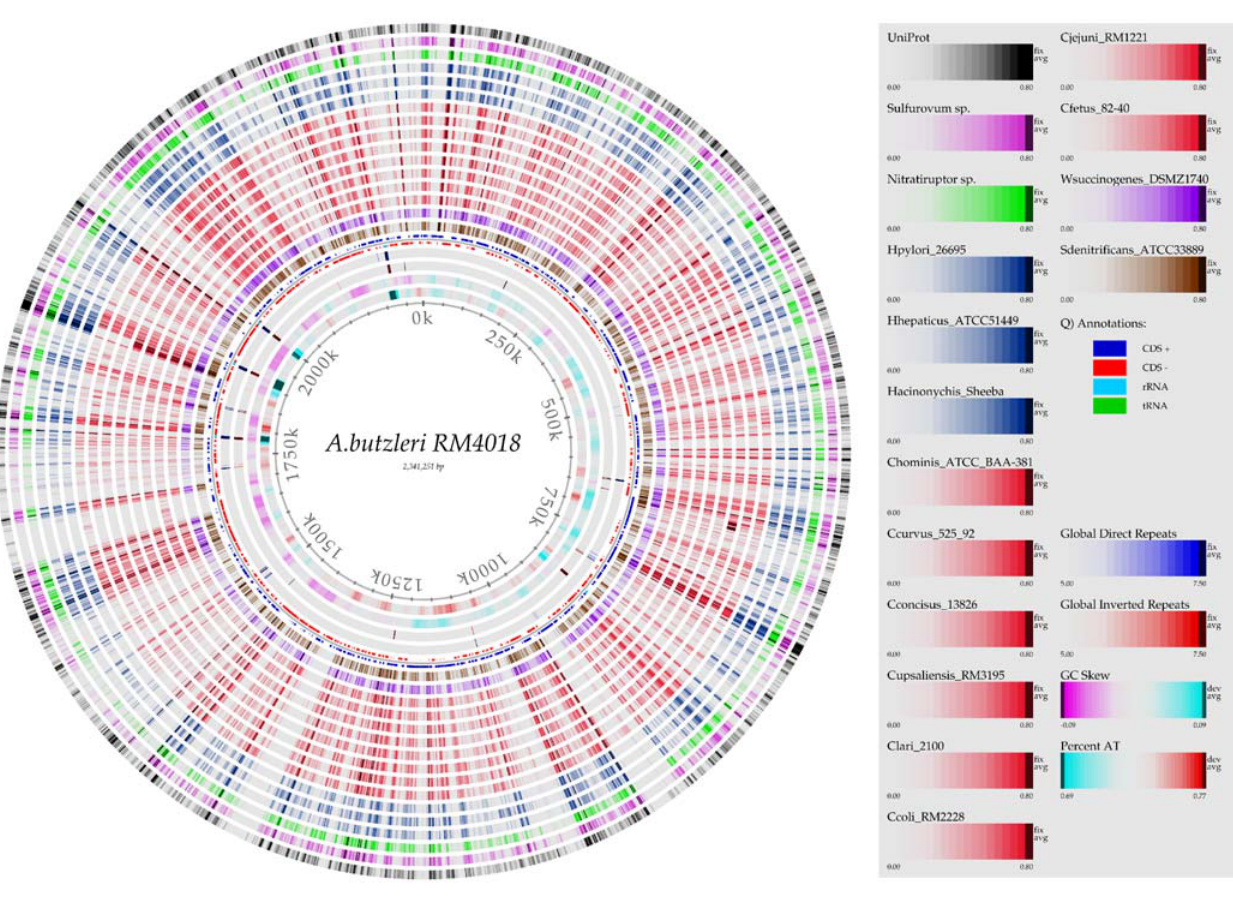
Figure 1. Genome BLAST atlas of theA.butzleristrain RM4018. Arcobacter butzleri strain RM4018 is the reference genome and is compared to a set of 15 other epsilonproteobacterial genomes, including different Campylobacter (rings 7–14 from center) and Helicobacter (rings 15–17 from center) strains, as well as the UniProt database (outermost ring in black). A web-based ‘‘zoomable atlas’’ can be found at [147].